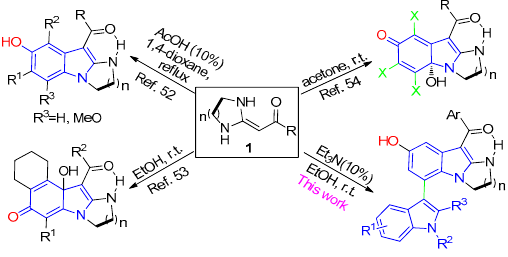
Figure 2. Synthesis of 3,7 ′ -bisindole derivatives based on the HKAs.